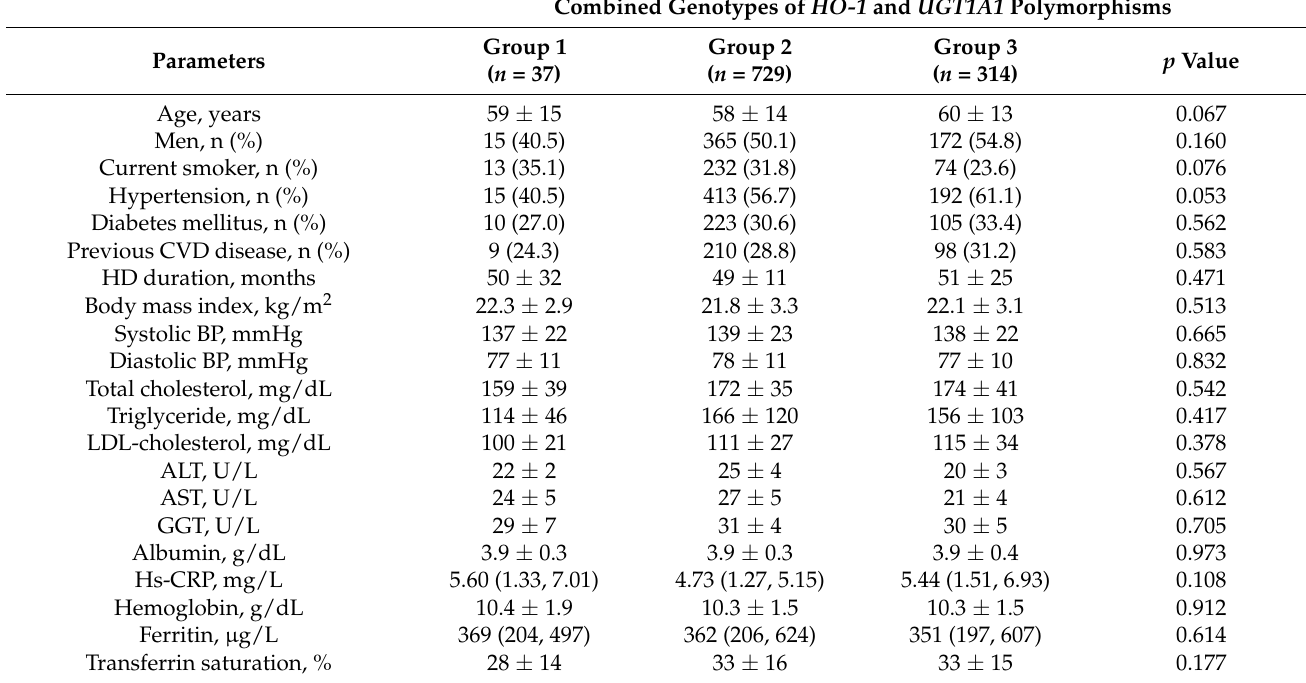
Table 1. Baseline demographic and laboratory characteristics of hemodialysis patients stratified by genotype combination of HO-1 and UGT1A1